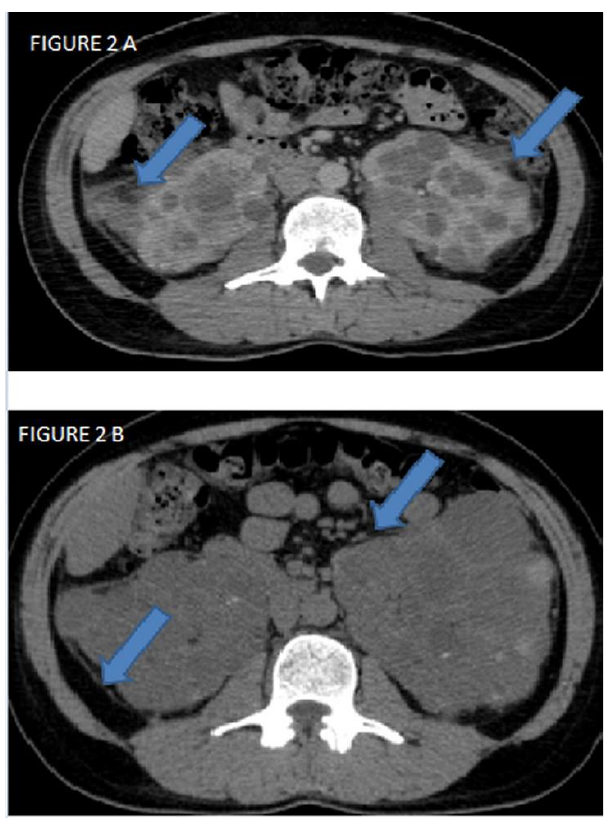
Figure 2 : Polycystic kidney and an infectious liquid collection behind the kidneys in the Abdomen CT scan (Figure 2A).Figure 2B reveals an abdominal CT scan after the treatment, observing that the infectious liquid collection formations in Figure 2A were regressed after the treatment as indicated by the